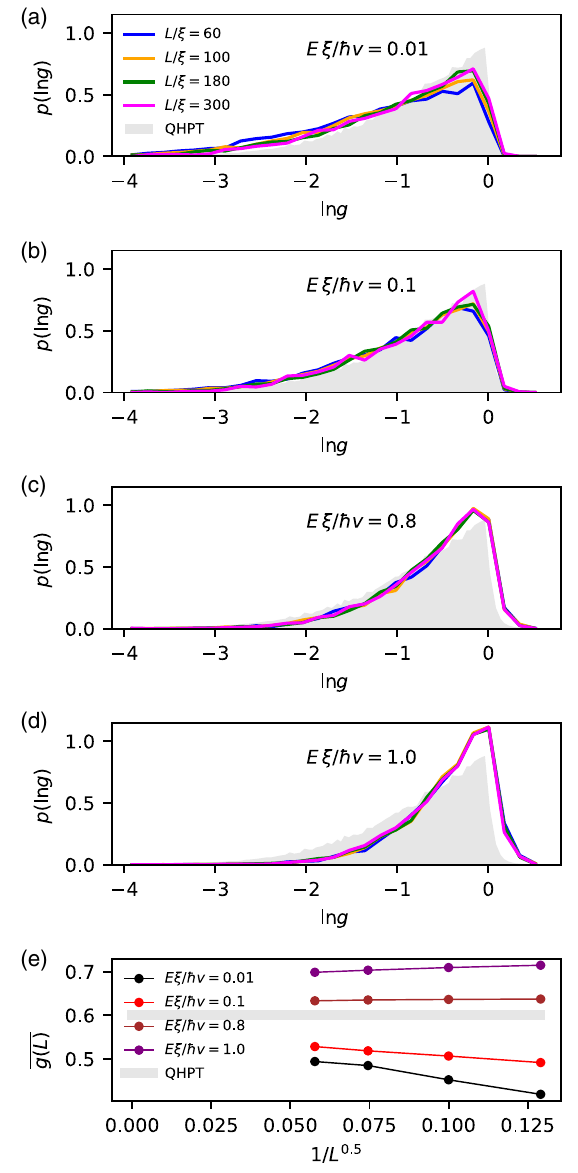
FIG. 3. Landauer conductance g (in units of e 2 =h ) of square samples of length L for the topological class AIII surface model with a single Dirac node ( ν ¼ 1 ), as in Fig. 2. The probability distribution p ð ln g Þ of the logarithm of the conductance for L= ξ ¼ 60 , 100, 180, 300 is depicted in (a) – (d) for energies E ξ = ℏ v ¼ 0 . 01 , 0.1, 0.8, 1.0, respectively. The data are based on between 1000 and 10000 disorder realizations, depending on system size. The gray filled area depicts the result obtained for a square-shaped Chalker-Coddington network model of size 128 reproduced from Ref. [39]. Panel (e) shows the scaling of the mean square conductance g ð L Þ for the above lengths and energies and the asymptotic value for the QHPT obtained from Ref. [40]. For the horizontal axis, the exponent on L has been chosen